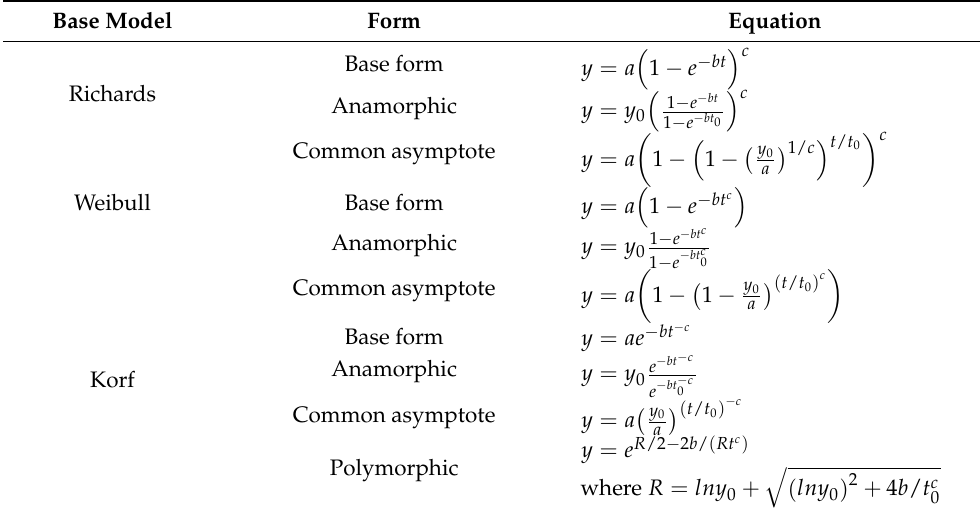
Table 2. Model forms tested for predicting a stand-level variable, y , as a function of stand age, t . Each model includes global model parameters c and a or b and an initial value of y , y 0 , at age t 0 . Base Model